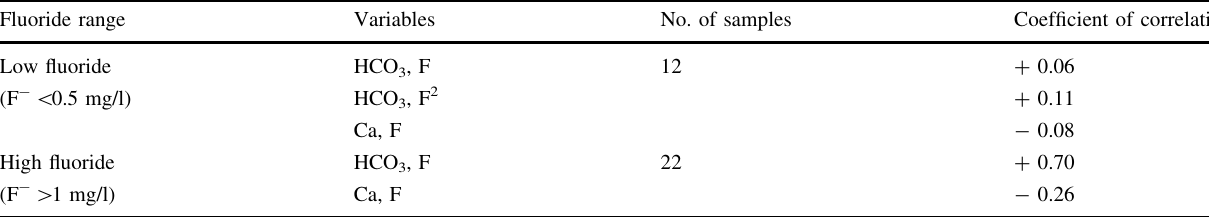
Table 2 Statistical relationships between some dissolved constituents present in GW from the study area Fluoride range